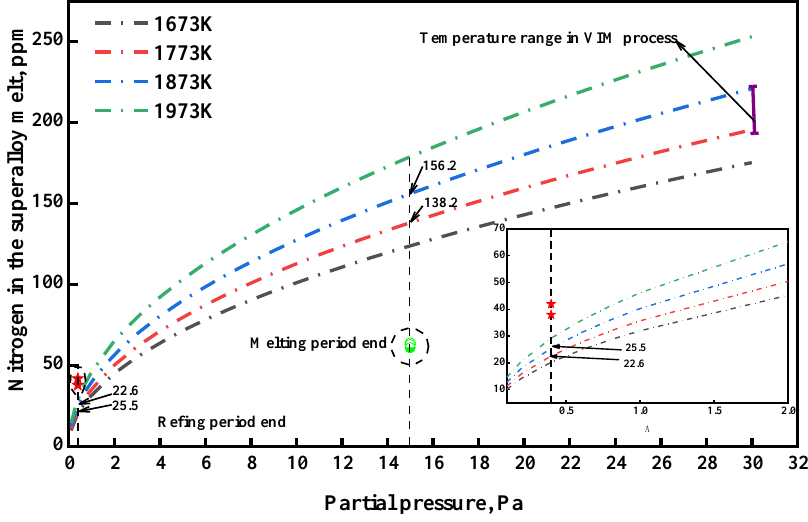
Figure 6. Nitrogen solubility at different partial pressures and temperatures.